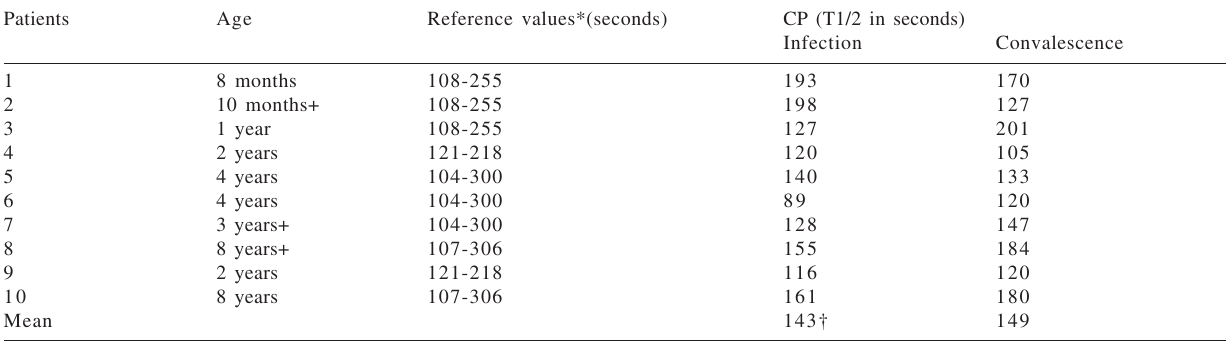
Table 1 - Classical pathway (CP) hemolytic activity, expressed as T1/2 (in seconds), during and after meningococcal